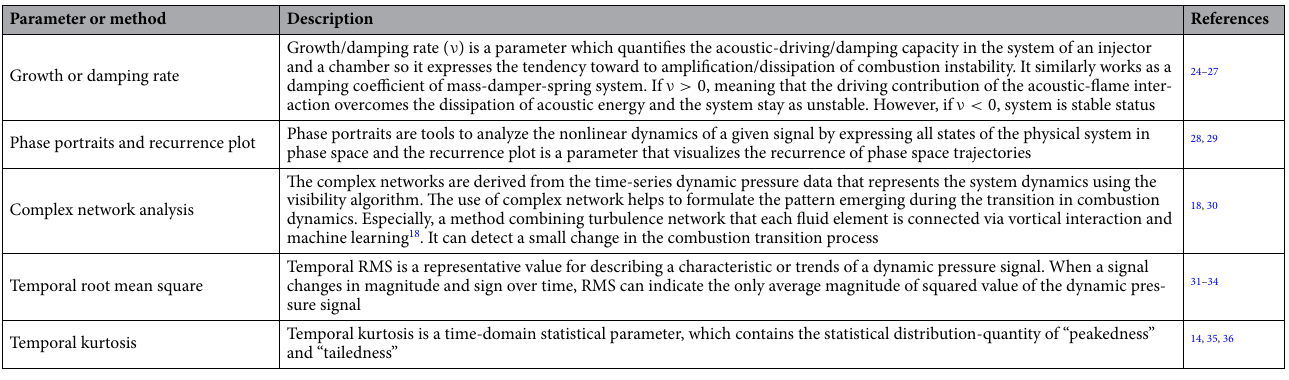
Table 1. Various parameters or analysis methods for evaluating combustion status.